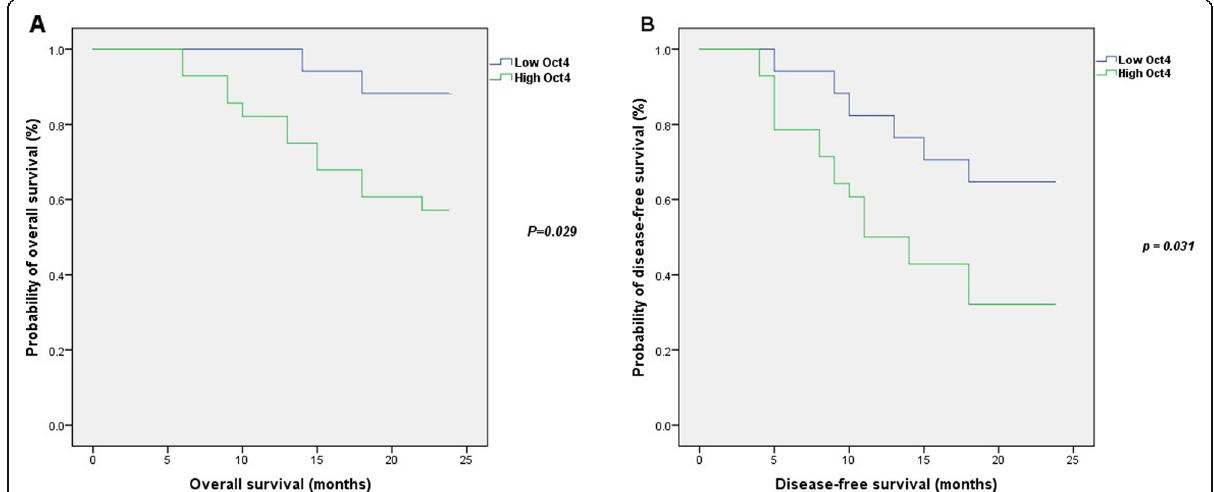
Fig. 7 Kaplan-Meier curves for overall survival (OS) ( a ) and disease-free survival (DFS) ( b ) of gastric cancer patients with high or low Oct4